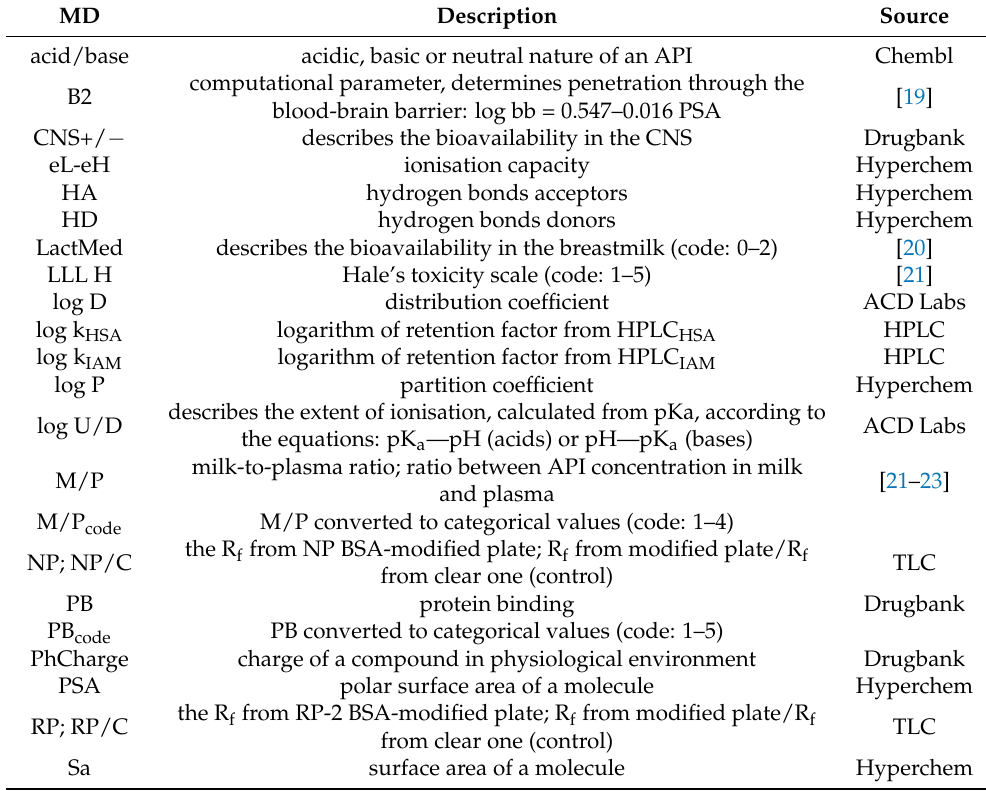
Table 2. List of molecular descriptors (MDs) used in statistical